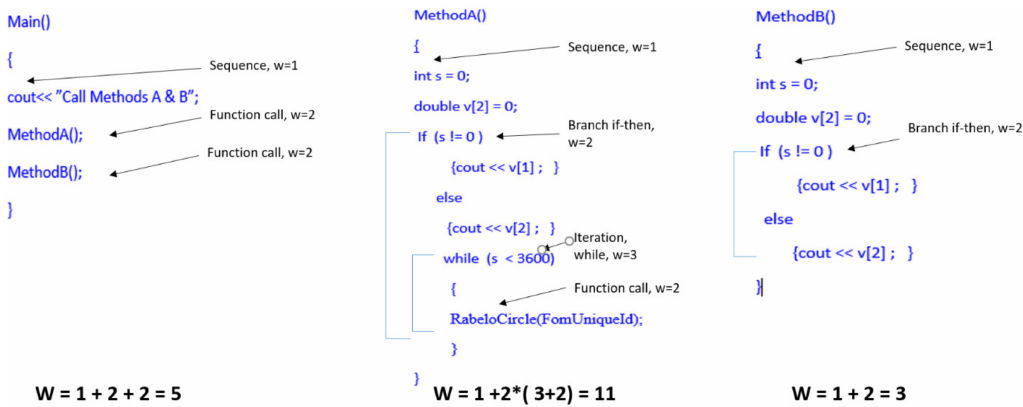
Figure 13. Calculation of the cognitive weights for a